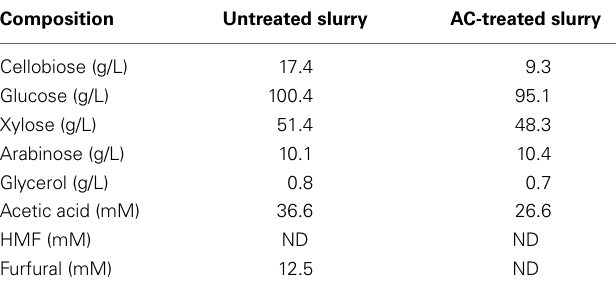
Table 3 | The compositions of deacetylated saccharified slurry before and after activated carbon (AC)